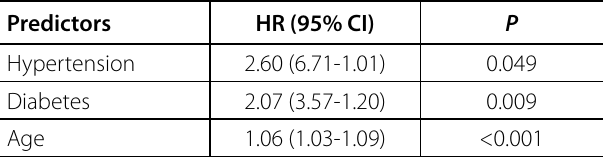
Table 3. Predictors for overall survival in patients who underwent CABG for stable angina (n = 282).